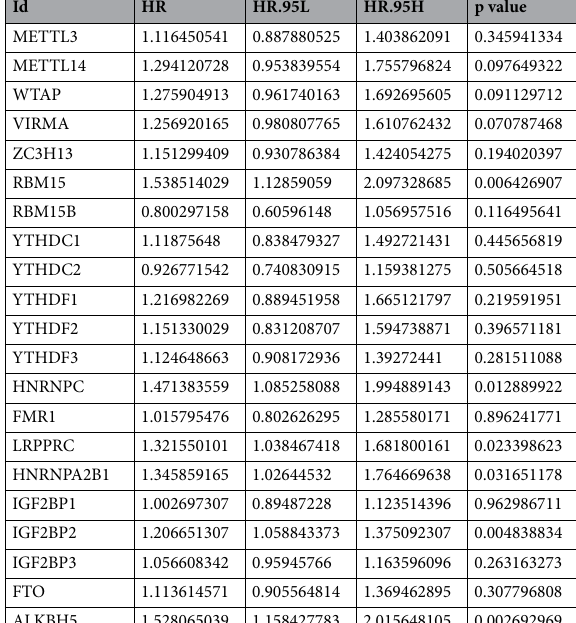
(Table 1) indicated that RBM15, HNRNPC, LRPPRC, HNRNPA2B1, IGF2BP2, and ALKBH5 were associated with a high risk of worse patient survival (p < 0.05), while only two genes (RBM15B, YTHDC2) were associated